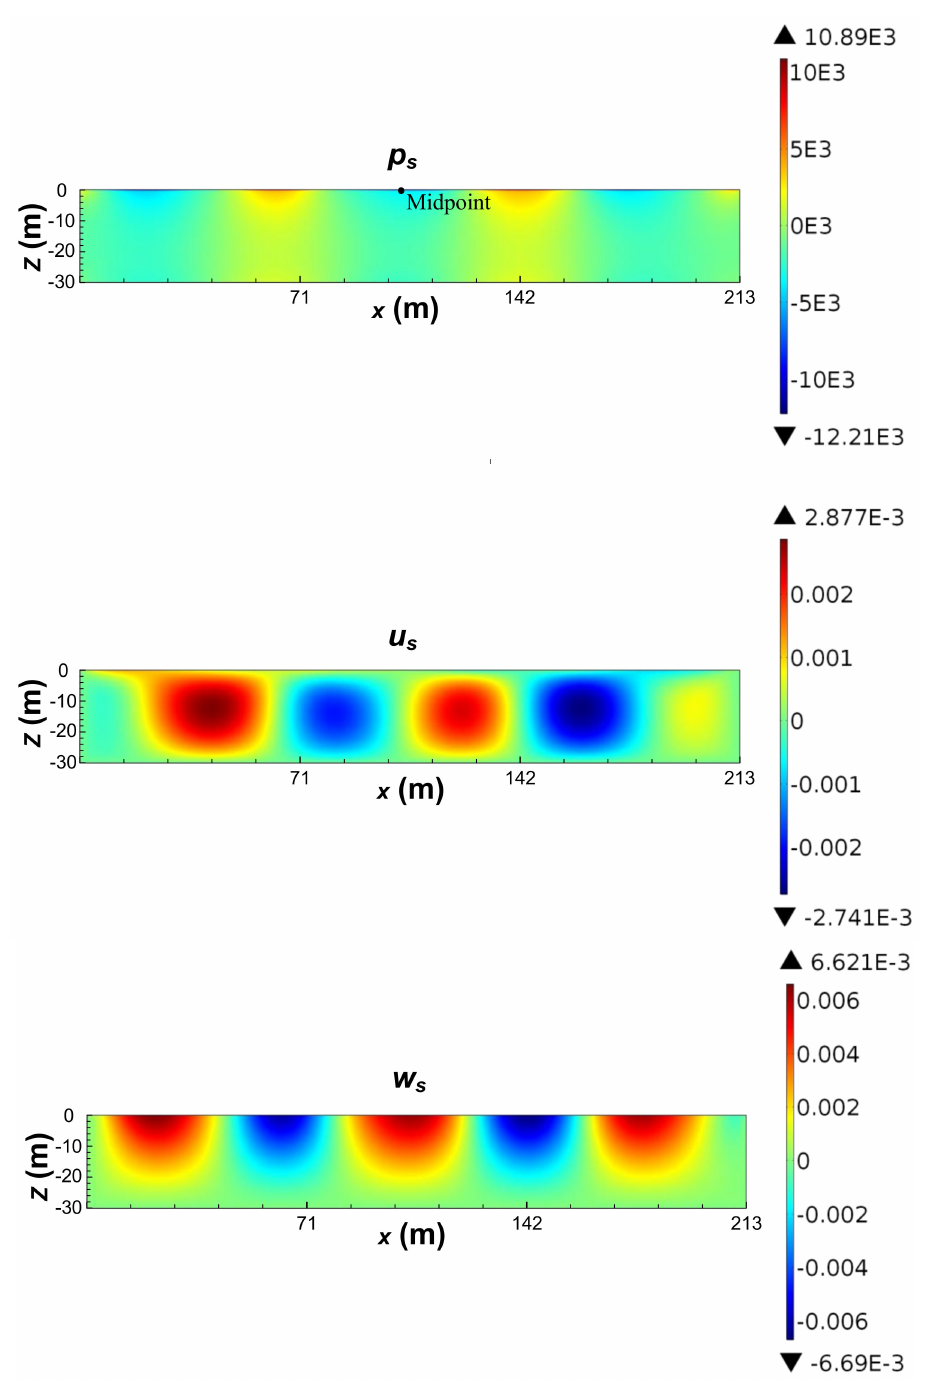
Figure 5. Seabed response to combined wave and current loading when current velocity v c = 0.5